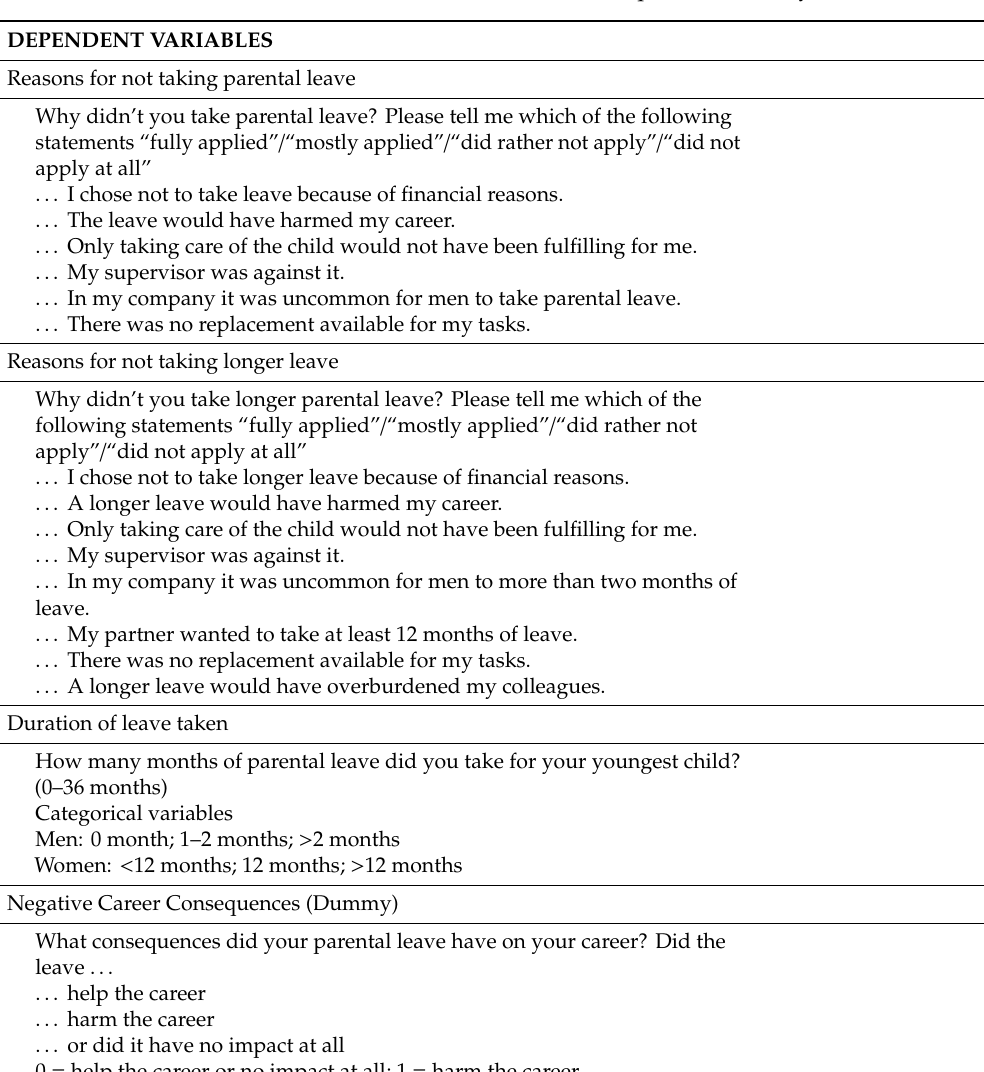
Table A1. Overview of the variables used in the quantitative